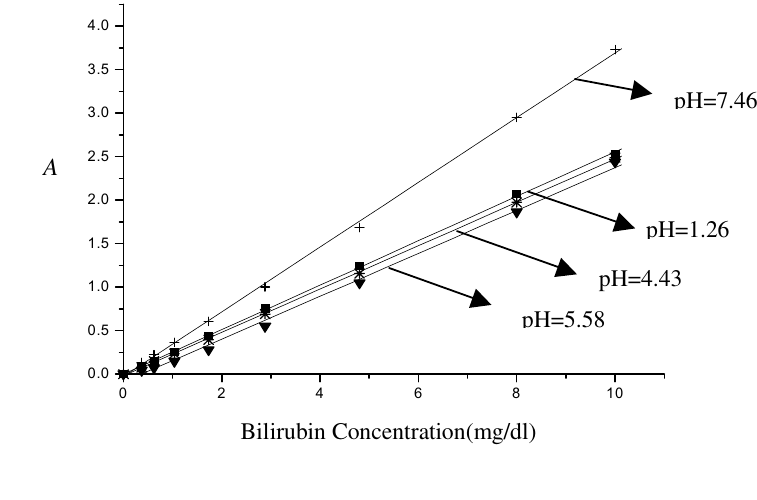
Figure 4. Bilirubin absorbance /concentration curves at different pH.